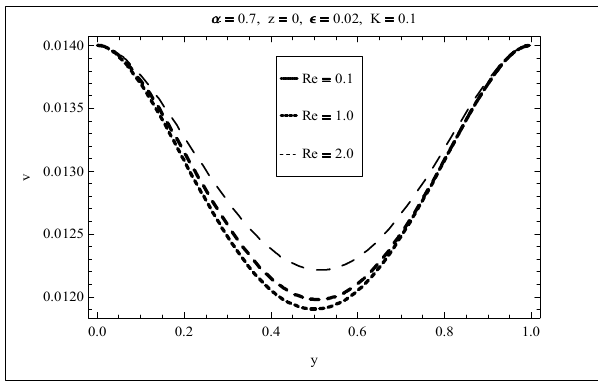
Figure 6. E ff ect of K on cross-flow velocity v along y . Figure 6. Effect of K on cross-flow velocity v along y .